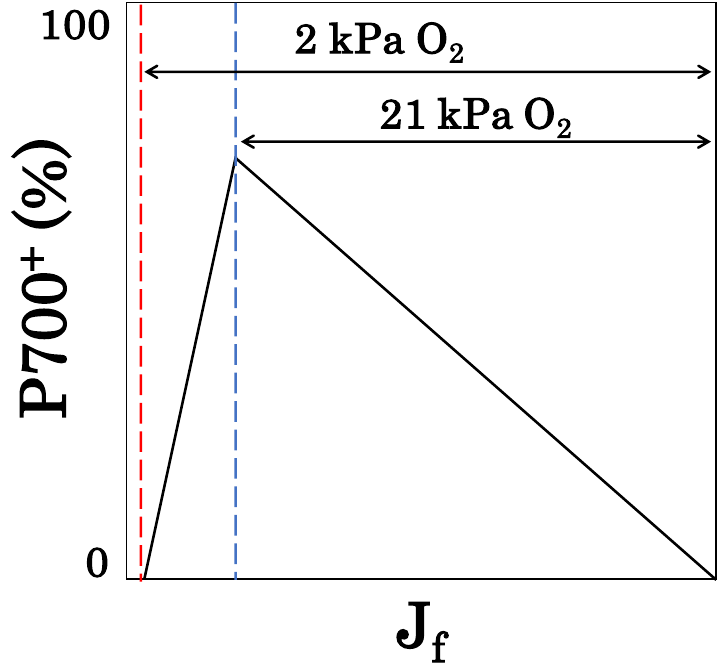
Figure 5. Dependence of oxidized P700 (P700 + ) induction on electron flux in photosynthetic linear electron flow in intact leaves. Generally, P700 is oxidized with a decreasing electron flux of photosynthetic linear electron flow (J f ) by lowering CO 2 partial pressure. At 21 kPa O 2 , when both photorespiration and photosynthetic CO 2 fixation are functioning, P700 + shows the maximum value at the CO 2 compensation point, while J f shows the minimum value (blue dotted line). The horizontal arrow at 21 kPa O 2 shows the range over which J f is driven by both photosynthetic CO 2 fixation and photorespiration. At 2 kPa O 2 , when no detectable photorespiration occurs and photosynthetic CO 2 fixation functions normally, P700 + starts to decrease to the minimum at the CO 2 compensation point after reaching its maximum value, while J f reaches its minimum value (red dotted line). The horizontal arrow at 2 kPa O 2 shows the range over which J f is driven by photosynthetic CO 2 fixation.